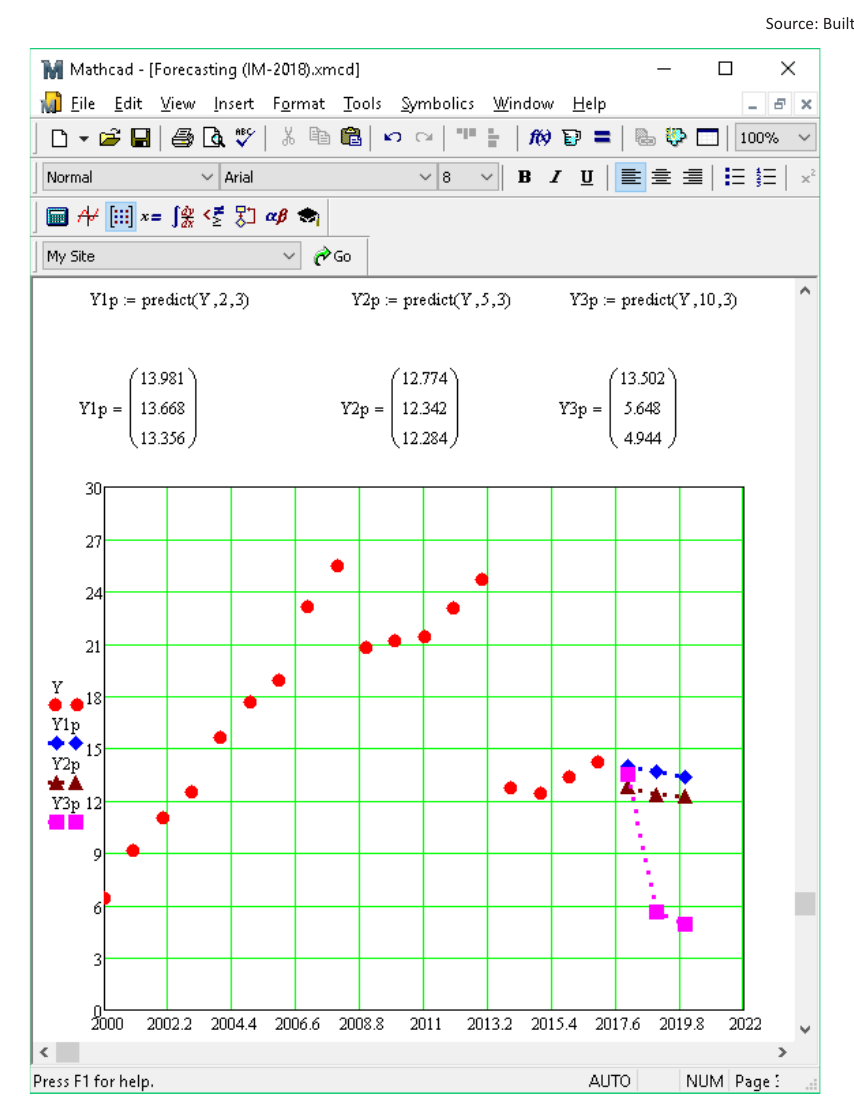
Figure 6. Building the forecasting models by predict function in MathCAD